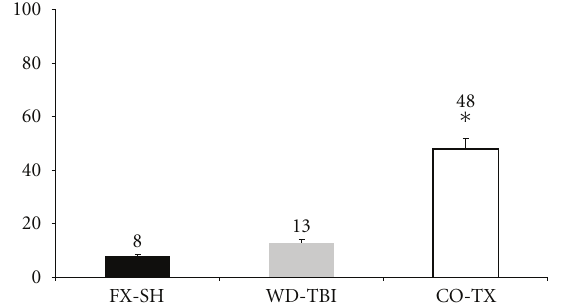
Figure 1: Mortality rates (%) of the 3 trauma subgroups. FX-SH: femur fracture and shock; WD-TBI: weight drop traumatic brain injury; CO-TX: combined injuries. ( ∗ ) P = 0 . 0263. The CO-TX group showed a significantly higher